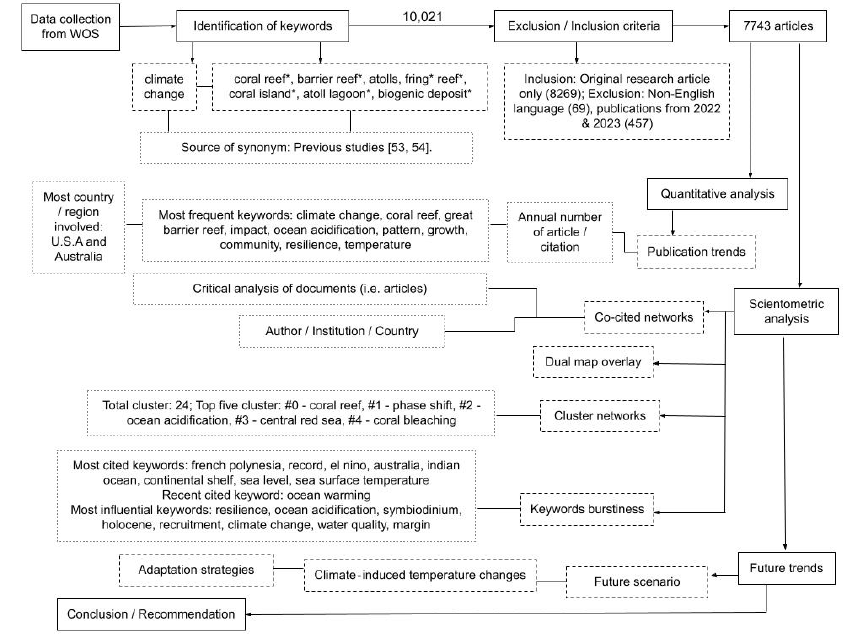
Figure 2. Article structure diagram.